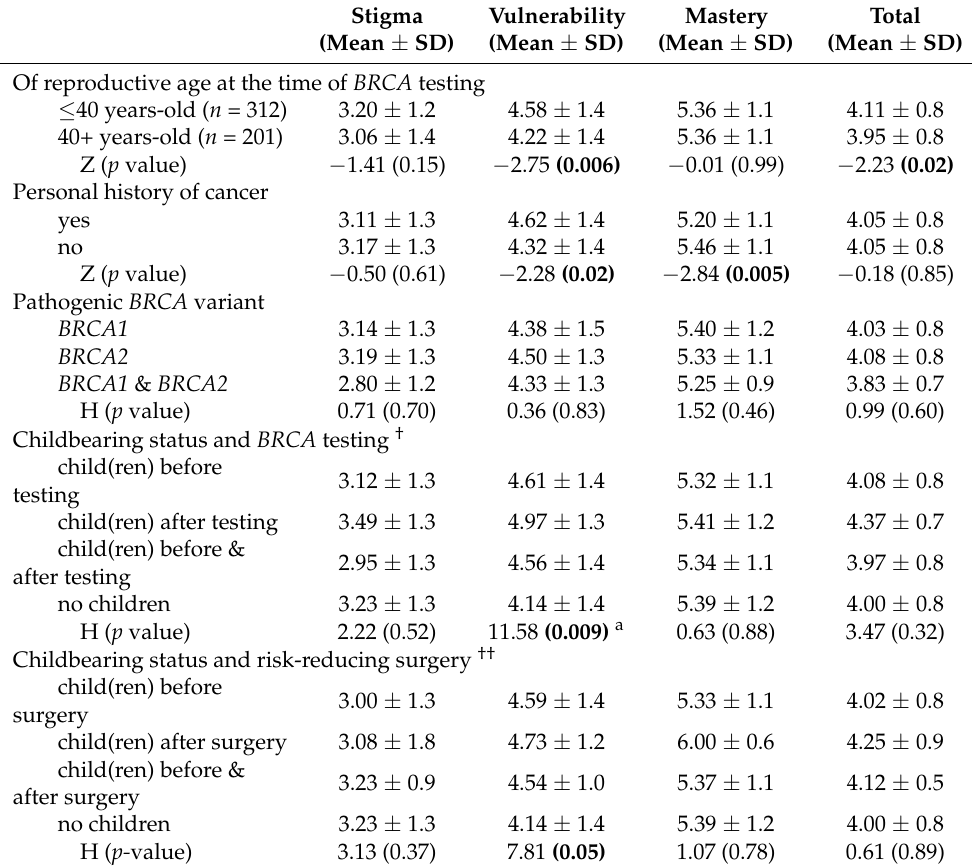
Table 3. BRCA self-concept scale scores in BRCA+ women ( n =